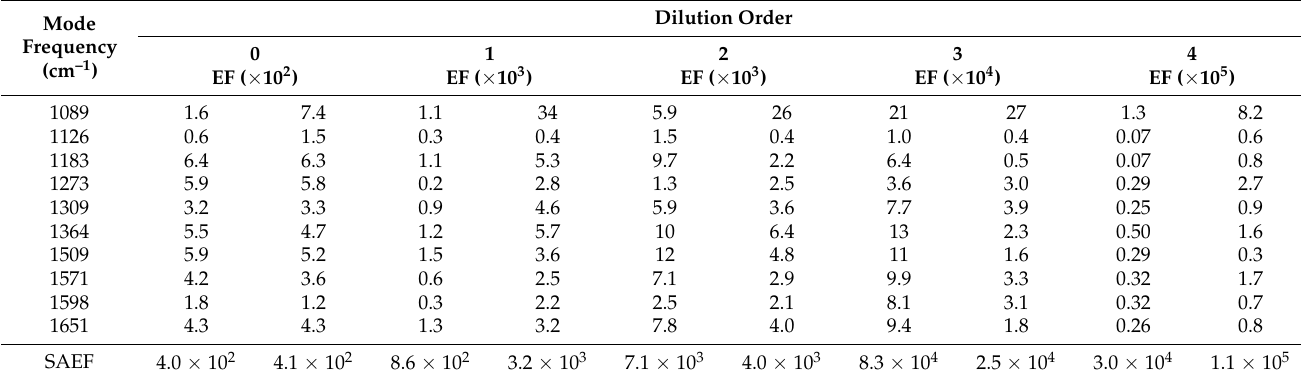
Figure 5a represents the concentration dependence of SAEF. For both types of sam- ples the SERS enhancement systematically increases at low concentrations, reaching op- timum values of ≈ 10 5 for samples treated in 10 − 6 –10 − 7 M R6G solutions. Figure